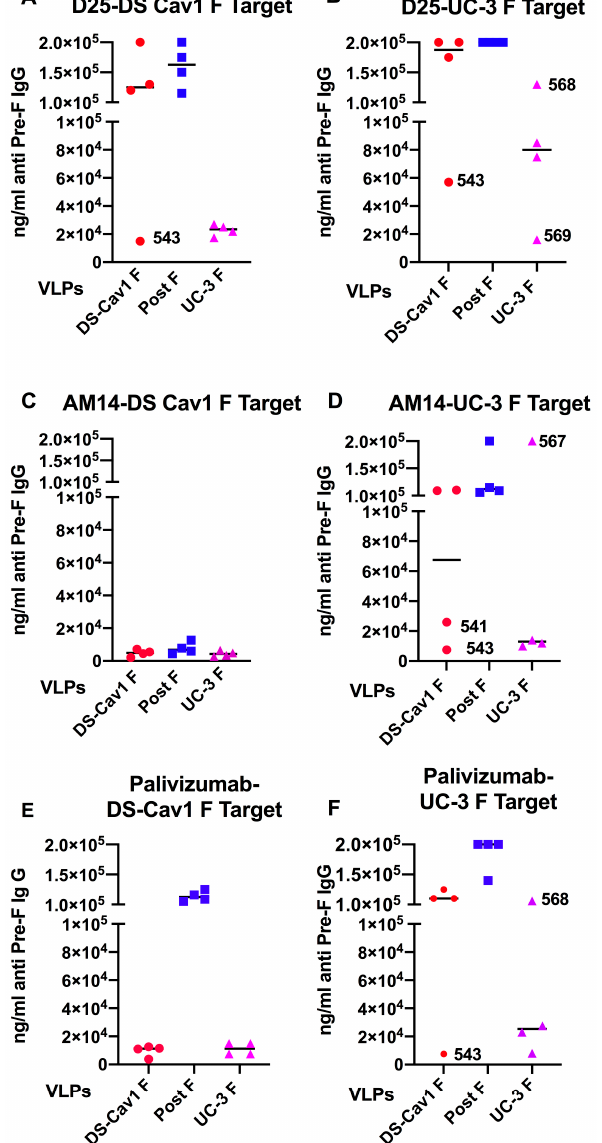
Figure 3. Blocking of binding of mAb by pup sera. The concentration (ng / ml) of anti-pre-F binding IgG required to block 50% binding of D25 (panels A, B), AM14 (panels C, D), or palivizumab (panels E, F) to soluble DS-Cav1 F (panels A, C, E) or UC-3 F protein (B, D, F) targets by ELISA. The sera of